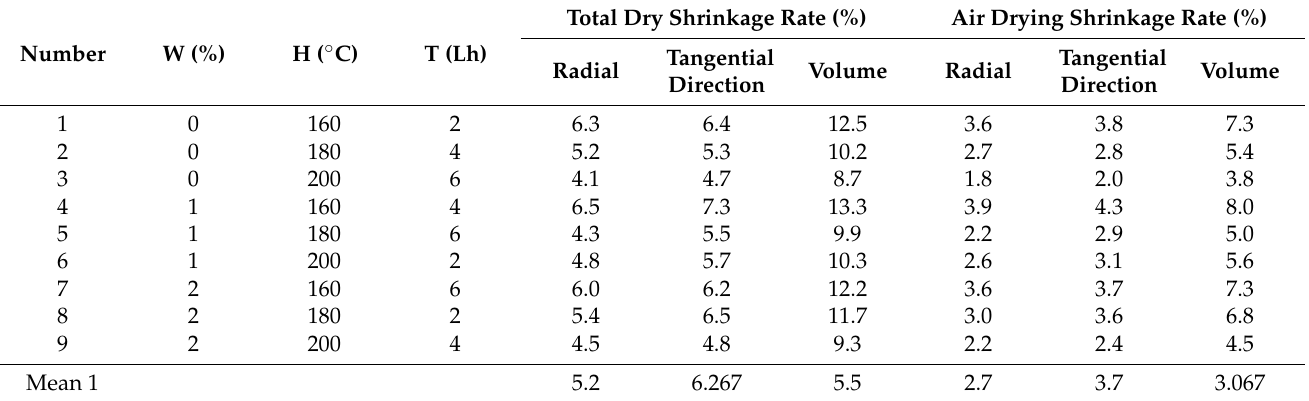
Table 6. Visual analysis of oven-dry and air-dry shrinkage of impregnated heat-treated